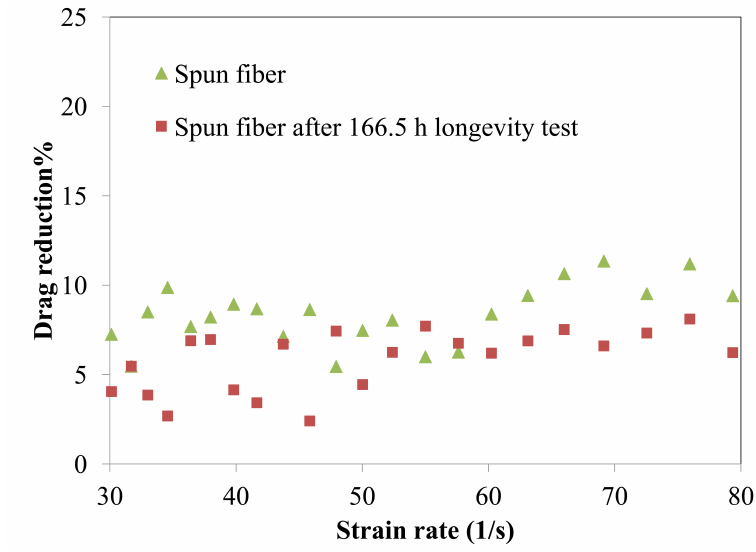
Figure 37. Drag reduction versus strain rate. From Samaha et al.